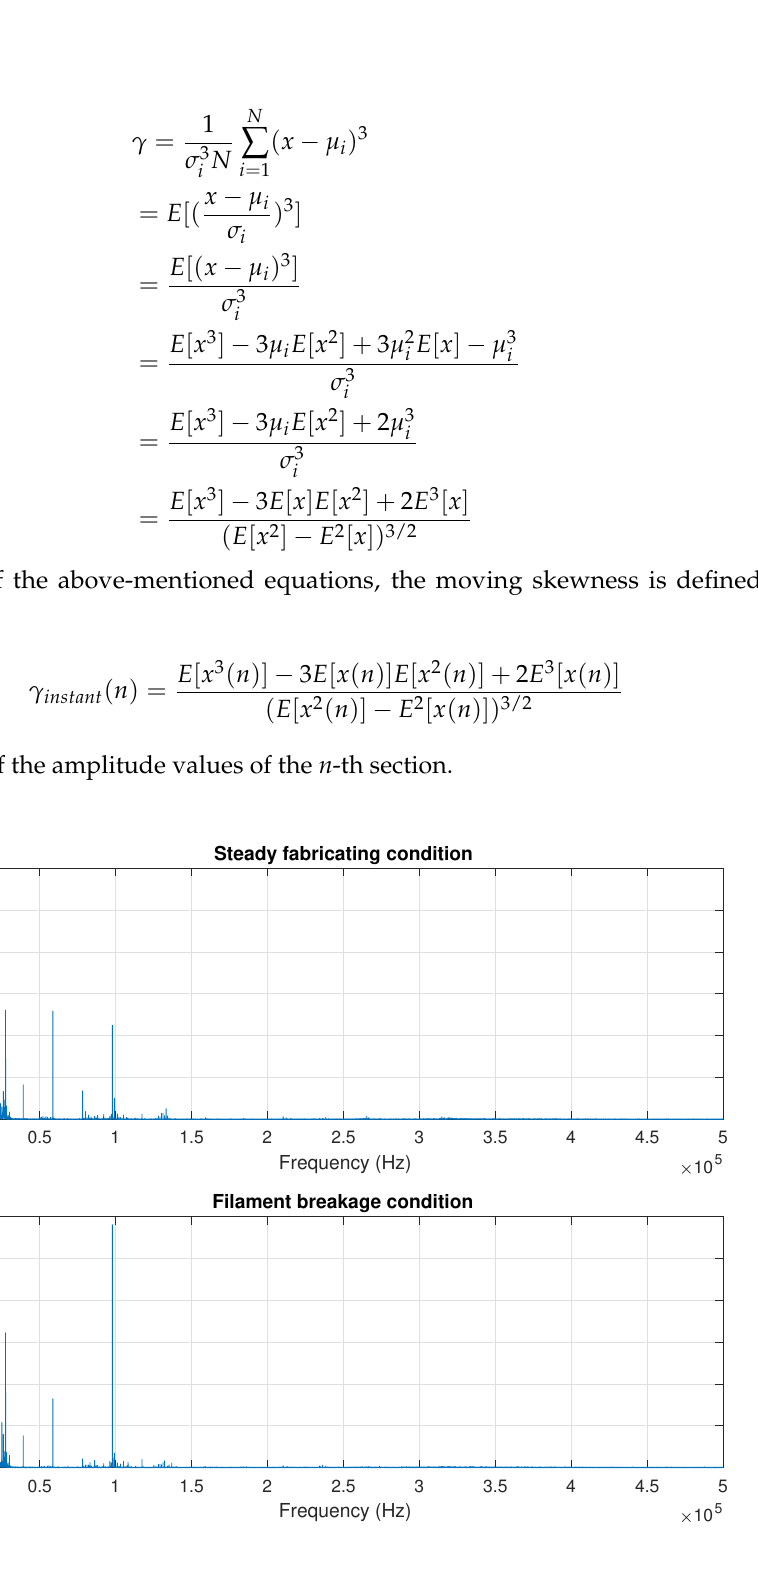
Figure 7. Amplitude spectrum of acoustic emission signals under different manufacturing